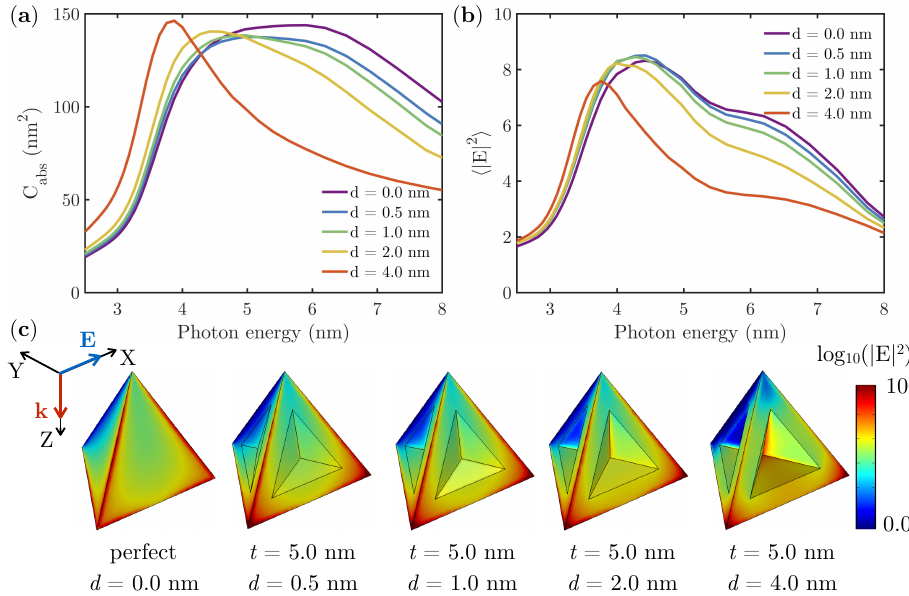
Figure 8. ( a ) Absorption cross-sections ( C abs ) of edge length L = 20 nm Rh TDs with a concavity with Figure 5. Absorption cross-sections ( C abs ) spectra of ( a ) cubes with R c = 5 nm with the same volume Figure 4. ( a ) absorption cross-sections ( C abs ) of edge length L = 30 nm Rh NCs with rounded edges increasing depth d while keeping its size constant t = 5 nm; ( b ) local field enhancement ( as those with L = 30 nm and R c indicated by the legend and ( b ) cubes with the same volume as a cube and corners with a curvature radii R c varying from 0 (perfect cube) to 15 nm (perfect sphere); ( b ) local over the TD’s surface; ( c ) local field enhancement in logarithmic scale ( with L = 30 nm and R c = 5 nm, but with an R c given by the legend. 2 ) averaged over the corners and edges (where charge is most concentrated) of field enhancement ( E different TD when illuminated with the corresponding resonant wavelength. | | the NC with different R c ; ( c ) local field enhancement in logarithmic scale ( different NCs when illuminated with the corresponding resonant wavelength.